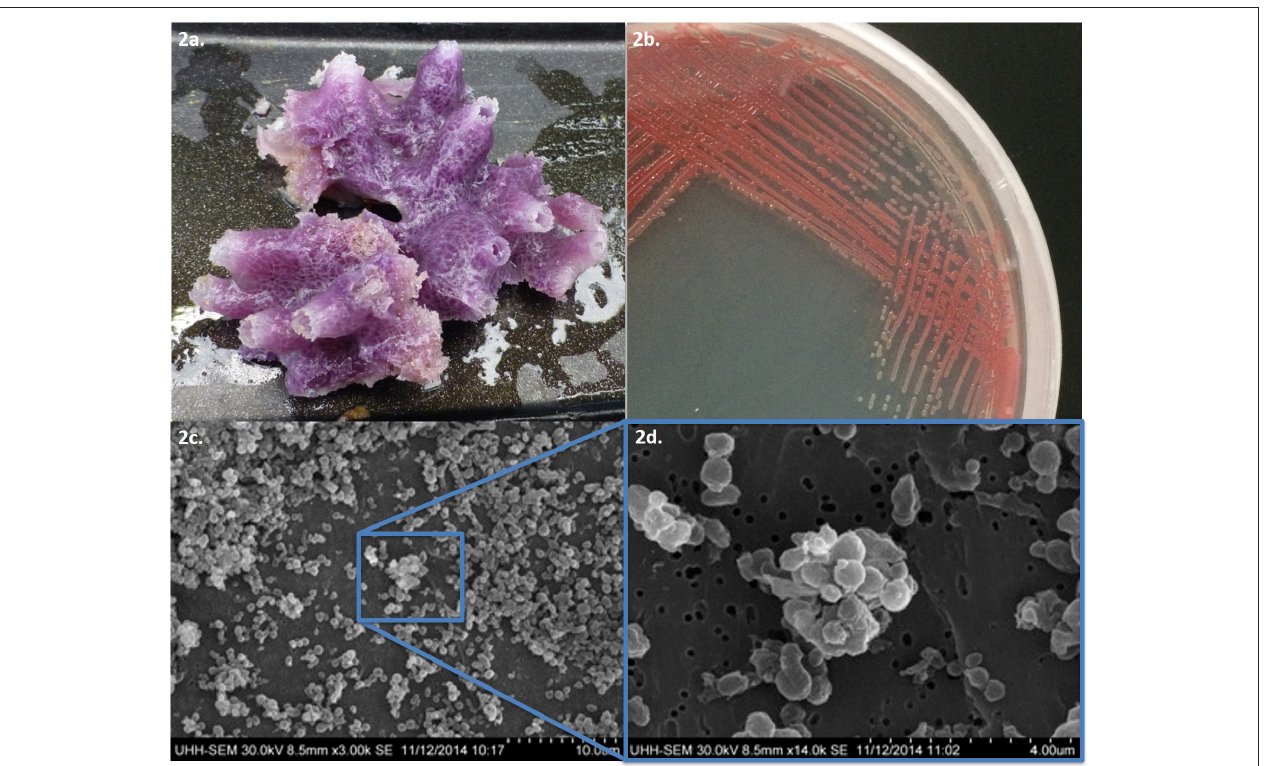
FIGURE 2 | (a) Tissue sample of Petrosia species and (b) pigmented microbial isolate PPB1. (c) Scanning electron microscope images of Pseudoalteromonas PPB1 field of bacteria and (d) magnified cluster of